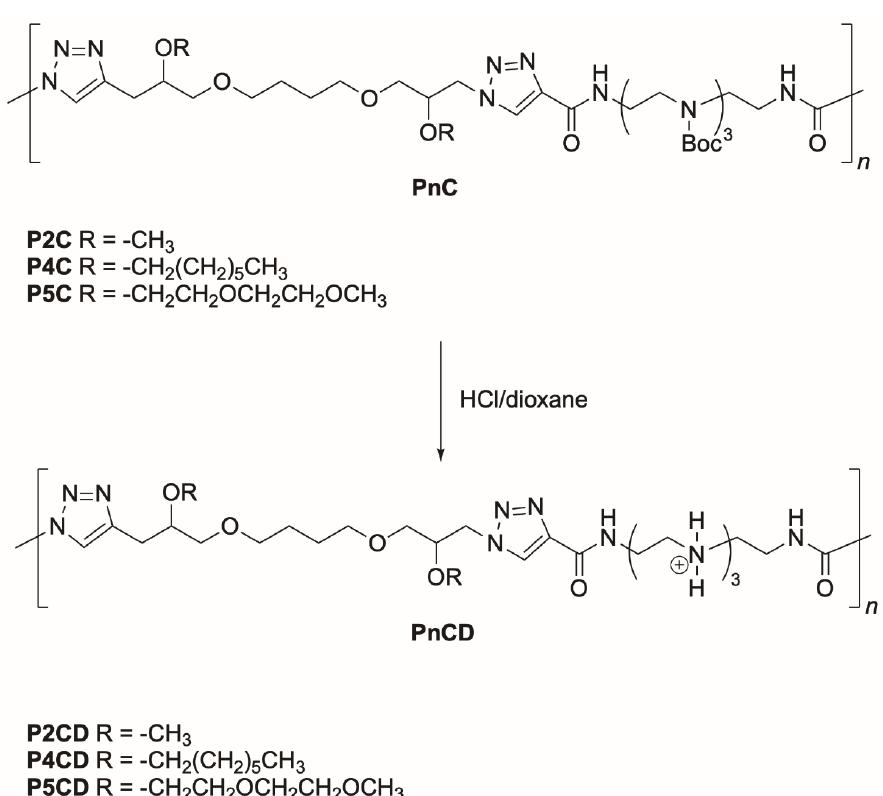
Figure 2. Structures of N -Boc protected polymers, PnC, prepared by CuAAC, and their corresponding deprotected polymers, PnCD.